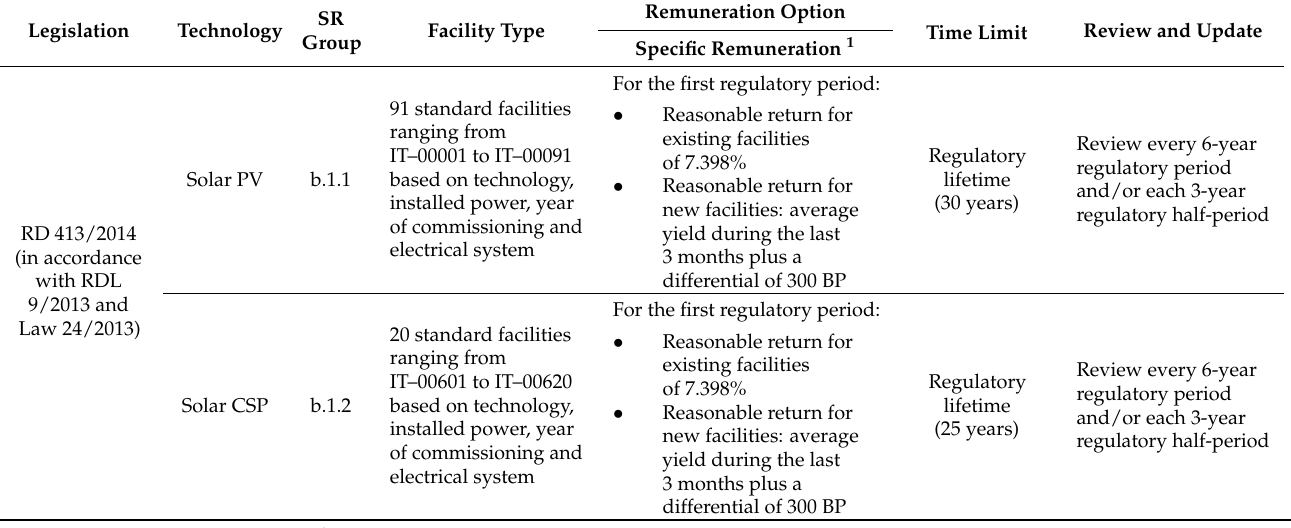
Table 11. Major characteristics of the different economic regimes in force for solar power systems in Spain in the period 2013–2020. Source: self-elaboration based on